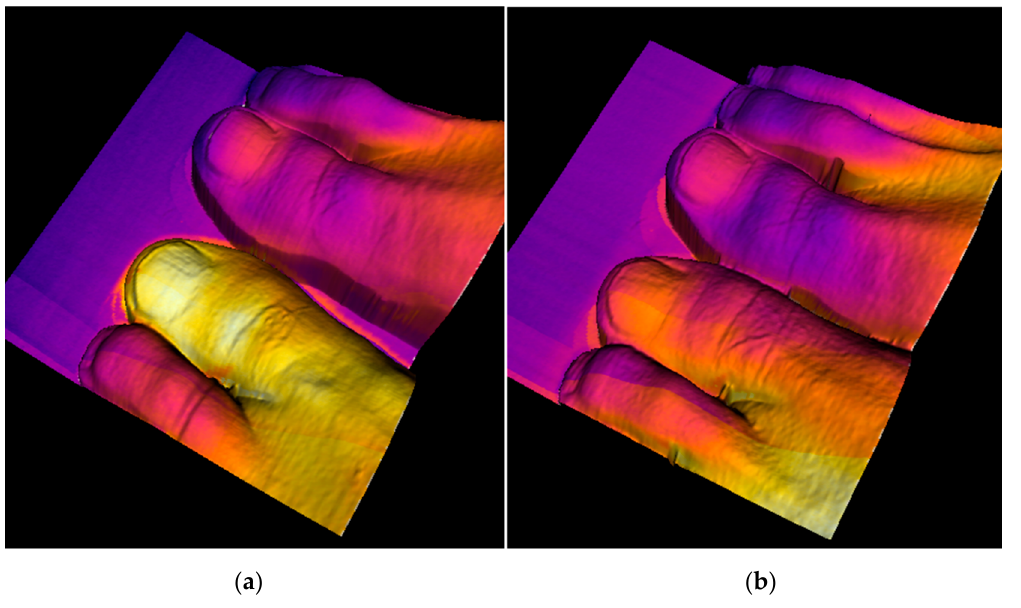
Figure 11. The injured toe captured 2 h ( a ) and 74 h ( b ) after the accident. The volume and the average temperature of the thumb appear to be reduced [35].